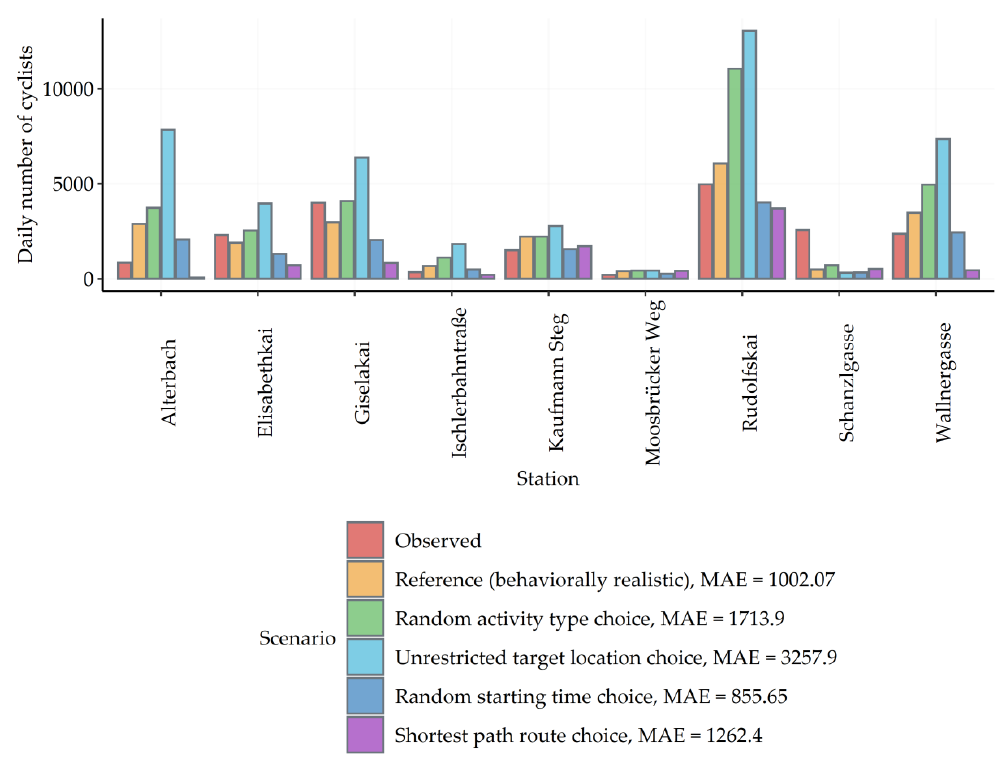
Figure 5. The box plot of the coefficients of variation of bicycle traffic volumes at random locations depending on the number of simulation runs. Each box represents coefficients’ mean, standard deviations, and maximum and minimum values.